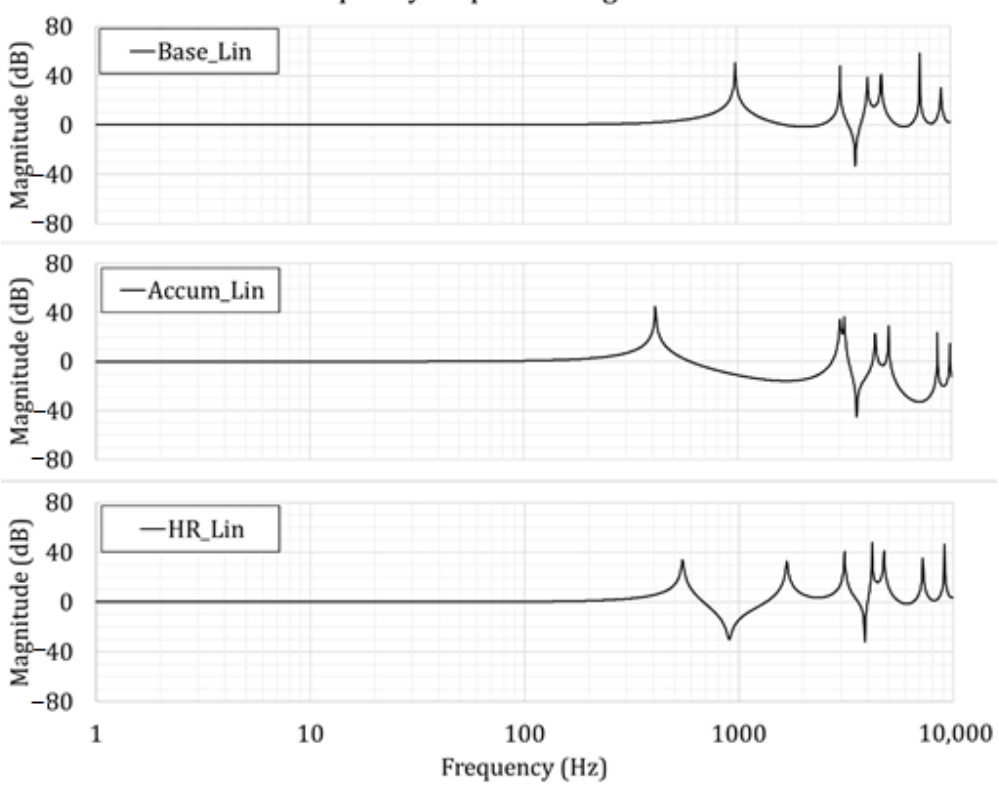
Figure 14. Frequency response of Base_Lin, Accum_Lin and HR_Lin. Table 7. Resonance frequency.